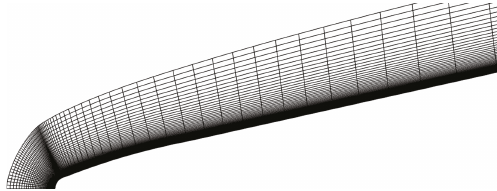
Figure 3: R1 model, mesh size (75,120,90).